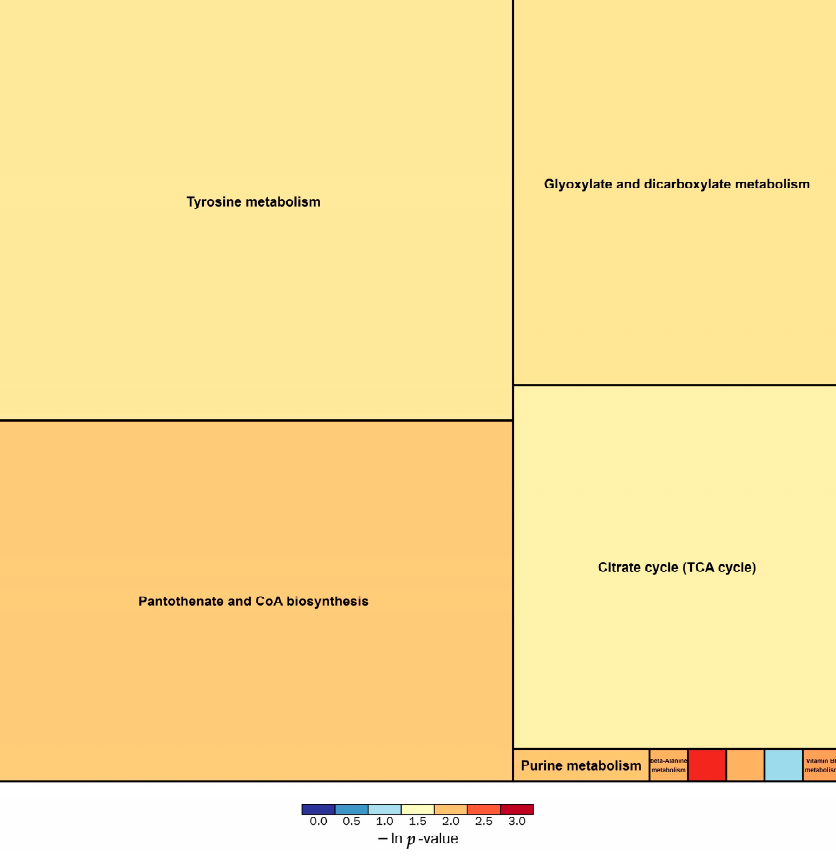
Figure 6. Pathway analysis for group SHLF vs. SHL.